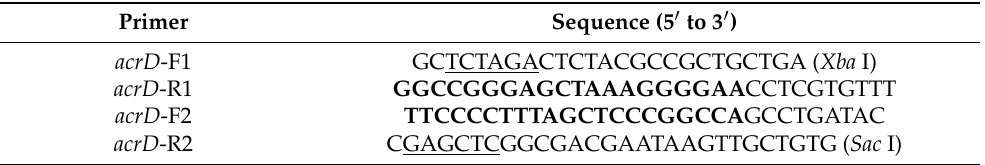
Table 1. Primers used for ∆ acrD mutant